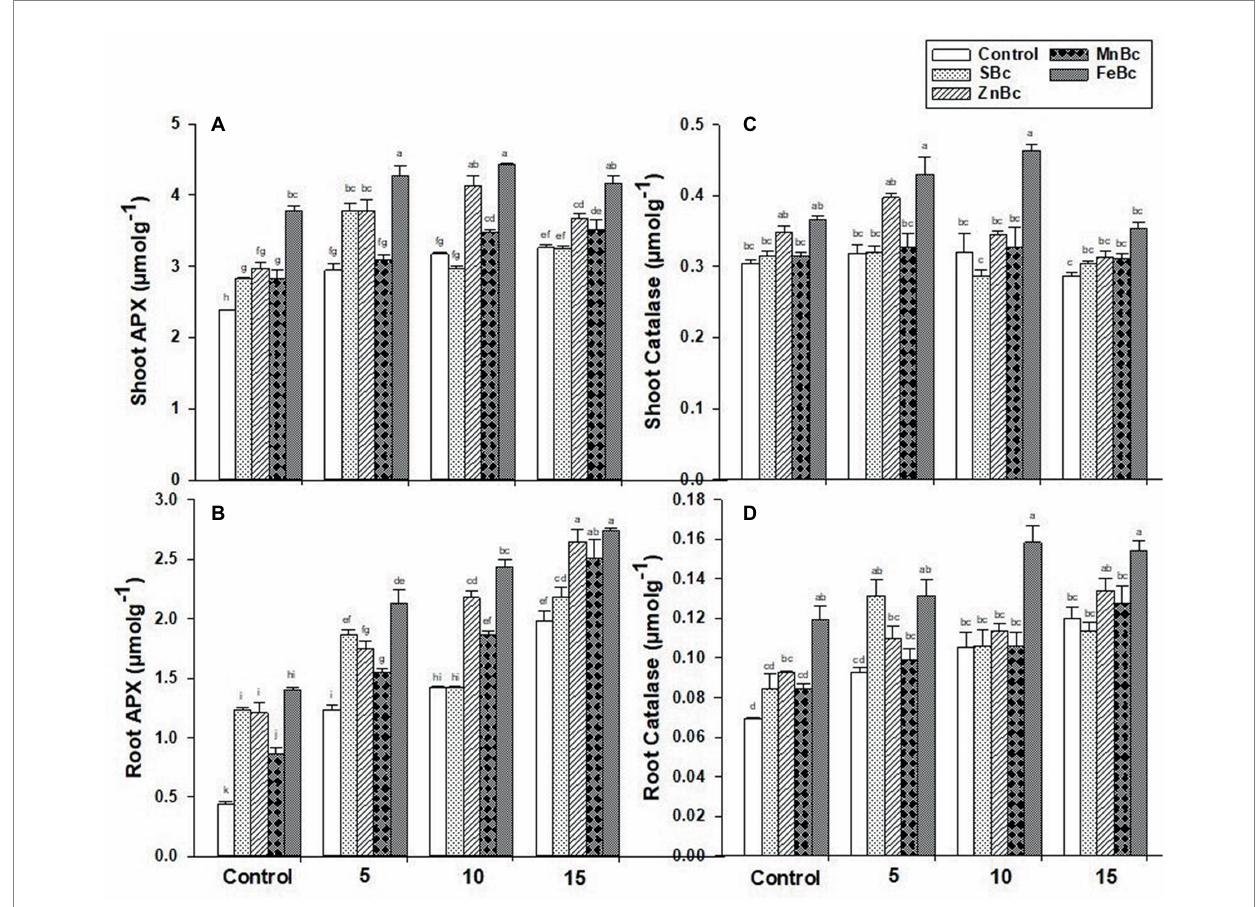
FIGURE 5 (A) Shoot APX, (B) Root APX, (C) Shoot Catalase, (D) Root Catalase of T. aestivum L. grown under various treatments such as T1 = DW, T2 = DW + 0.1% SBc, T3 = DW + 0.1% ZnBc, T4 = DW + 0.1% MnBc, T5 = DW + 0.1% FeBc, T6 = 5dSm − 1 BW, T7 = 5dSm − 1 BW + 0.1% SBc, T8 = 5dSm − 1 BW + 0.1% ZnBc, T9 = 5dSm −